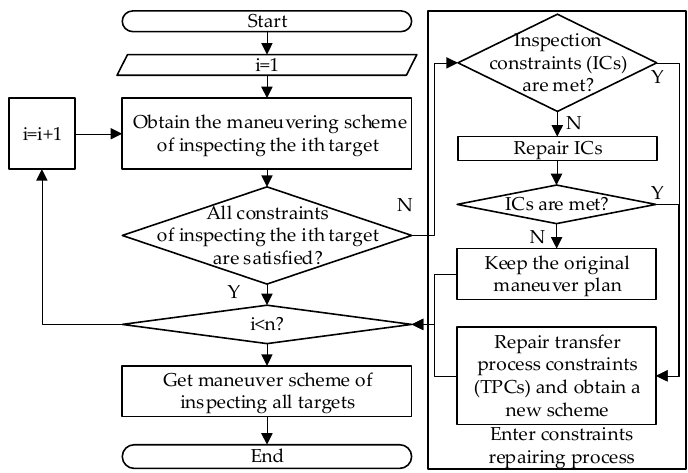
Figure 3. Calculation flow chart based on constraint repairing.